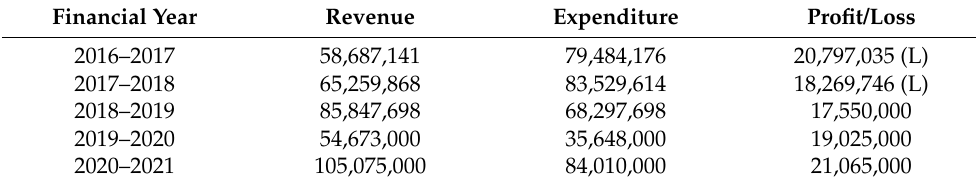
Table 5. Profit and Loss Statement (2016–2021) (In Crores). Financial Year Revenue Expenditure Profit/Loss